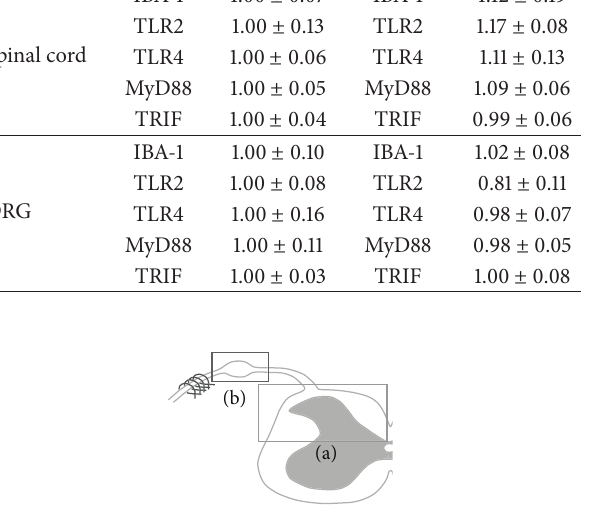
Figure 4: (a) Spinal cord and (b)